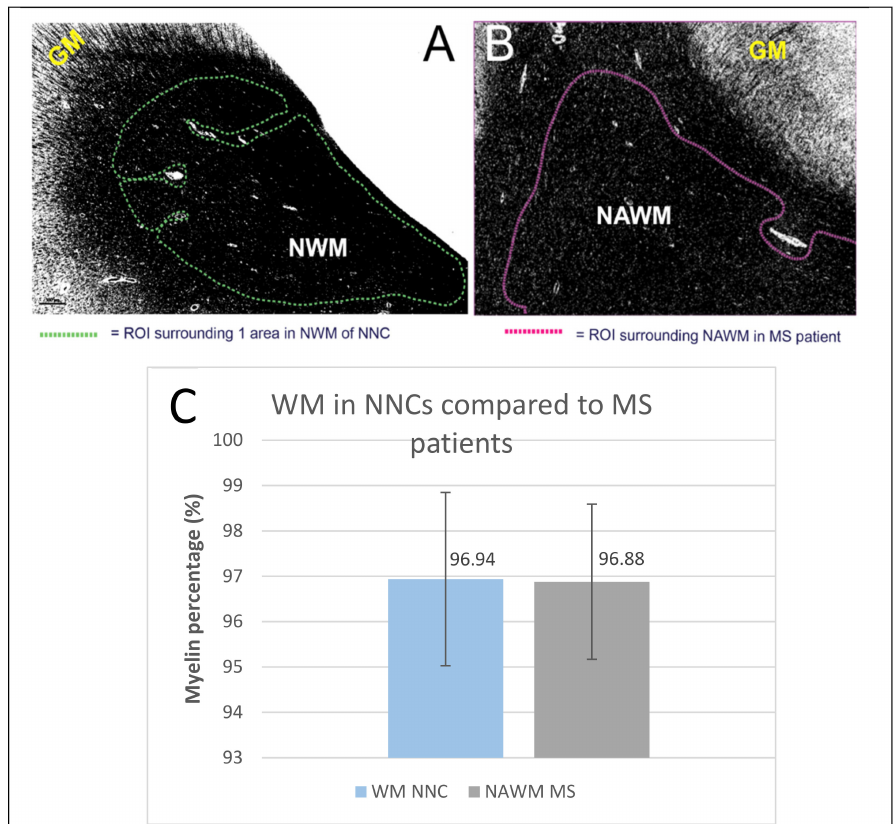
Figure 3. NAWM and NWM thresholded images for myelin density computation. ( A ) represents one of the three thresholded NWM images of a NNC brain section, illustrated with one ROI; ( B ) represents a thresholded image and ROI of NAWM in a MS brain section. LFB = luxol fast blue, NWM = normal white matter, GM = grey matter, NNC = non-neurological control, ROI = region of interest; ( C ) Bar graph representing the difference in WM quantity between NNCs (mean: 96.94%; SD 1.91%) and MS patients in the normal (appearing) white matter (mean: 96,88%; SD 1.71%). p =